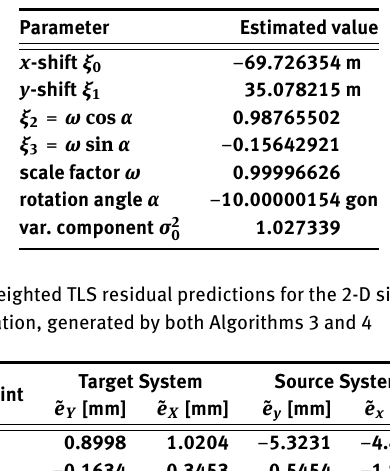
Table 2. Weighted TLS estimates for the 2-D similarity transforma- tion, generated by both Algorithms 3 and 4